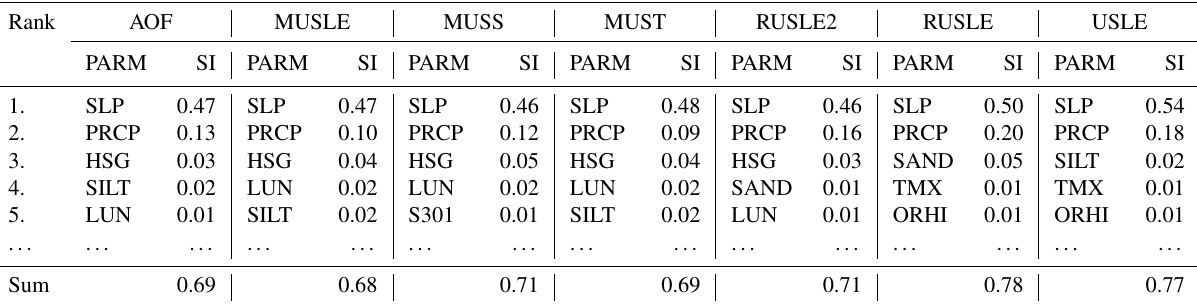
Table 4. First-order sensitivity indices (denoted SI) ranking for the five most sensitive input parameters (PARM) for each water erosion equation including slope steepness (SLP), daily precipitation (PRCP), soil hydrologic group (HSG), land-use number (LUN), soil silt content (SILT), soil sand content (SAND), curve number parameter (S301), maximum air temperature (TMX) and crop residues left after harvest (ORHI). The sensitivity indices of the remaining parameters are presented in Table S3.